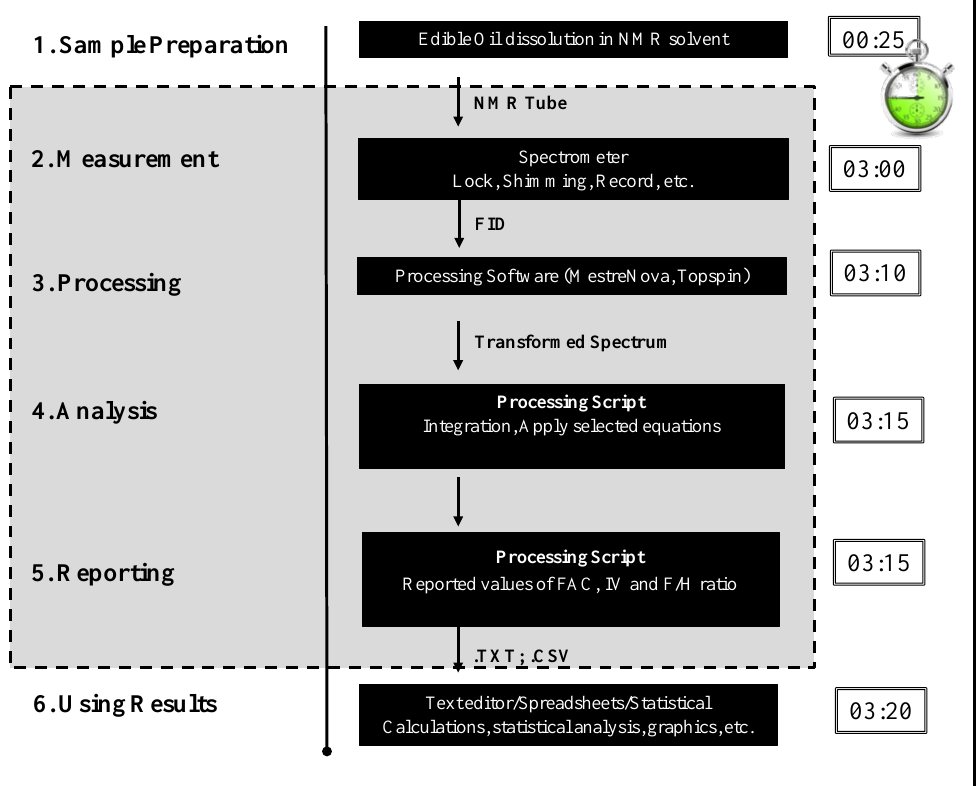
Figure 4. Scheme illustrating the general workflow for the automatic edible oil analysis: ( 1 ) Performing the (quantitative) NMR experiment itself and recording the FID; ( 2 ) Transforming the FID with FT to a spectrum and applying all associated processing steps (apodization, phasing, baseline correction, etc. ); ( 3 ) Using the processing script to extract the information from the spectra; ( 4 , 5 ) Using the information provided by the processing script for plotting or further analysis, such as statistics; ( 6 ) Export the reported values of FAC, IV and F/H ratio to other programs.